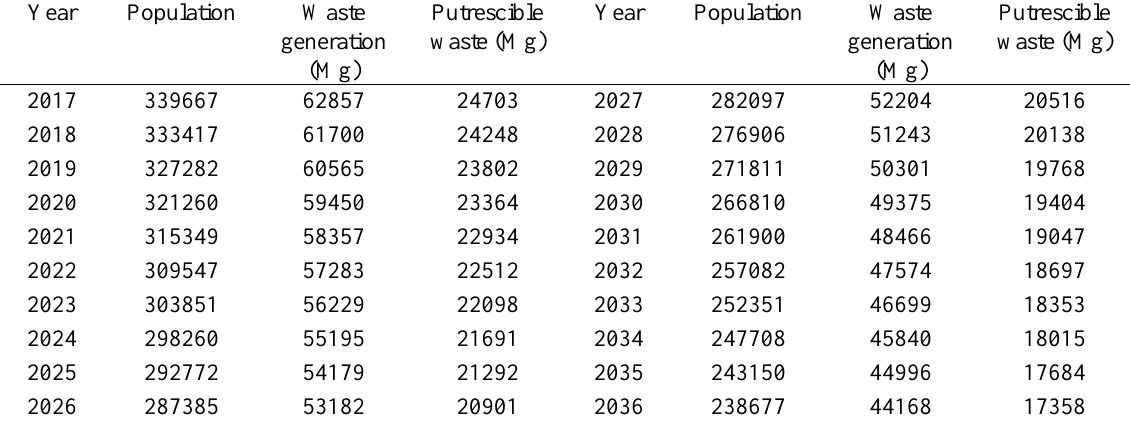
Table 2 . The population and amount of waste generated in the period 2016-2036 Chaharmahaal and Bakhtiari